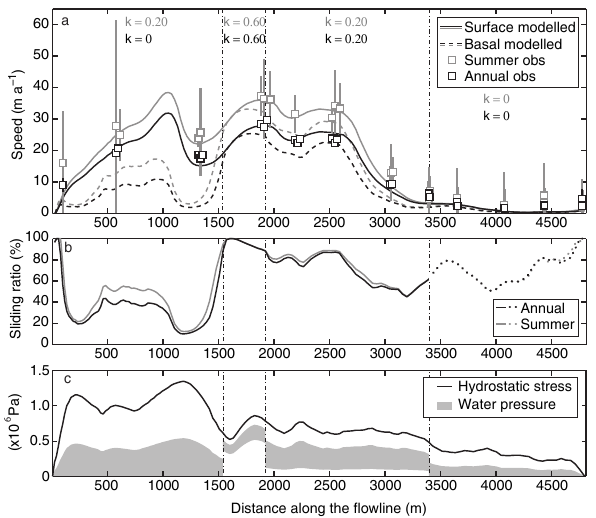
Fig. 6. Modelled flow speeds and inferred basal conditions along the flowline. (a) Measured (squares) and modelled surface- (solid lines) and basal (dashed lines) flow speeds with A = 2 . 4 × 10 − 24 Pa − 3 s − 1 , m max = 0 . 25, λ max = 6m and a prescribed distri- bution of basal water pressure P w = kρgh . Flotation fraction k is constant over the intervals defined by the vertical dot-dashed lines. Uncertainties are shown as vertical bars for each measurement and are often smaller than the squares for annual flow speeds. (b) Mod- elled contribution of basal flow relative total surface motion for the annual and summer profiles in (a) . Dotted segments should not be interpreted due to the very low flow speeds. (c) Ranges of pre- scribed basal water pressure P w consistent with the annual observa- tions for a range of friction law parameters, plotted with the basal hydrostatic stress ( ρgh ).